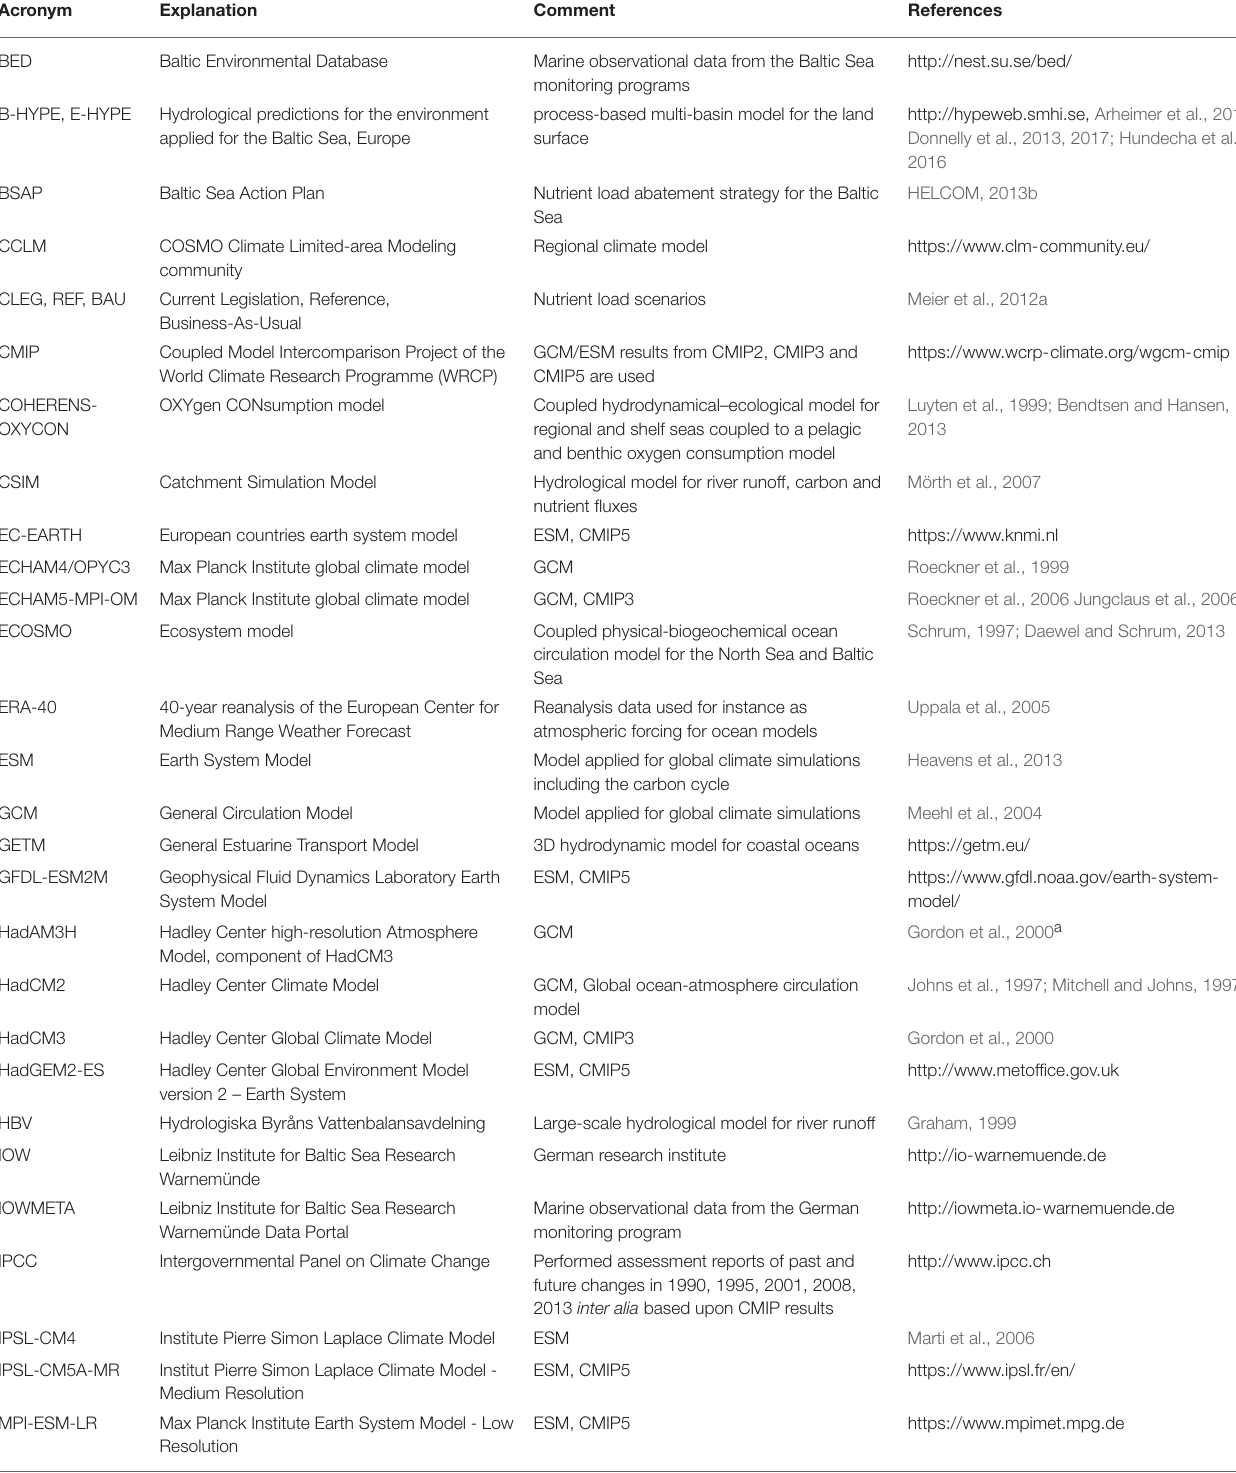
TABLE 3 | List of acronyms, their explanation and references (in alphabetical